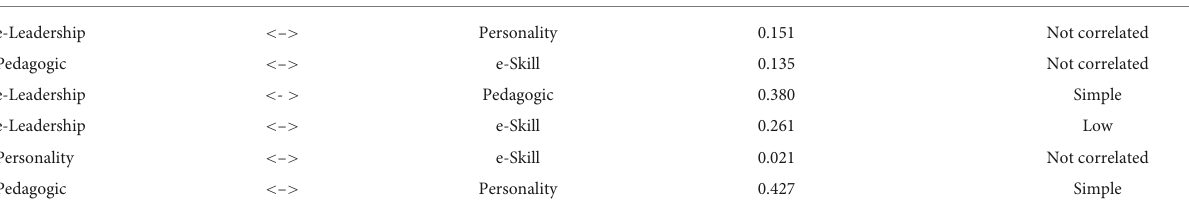
TABLE 11 The strength of the relationship between independent variables (Group number 1—Default model).